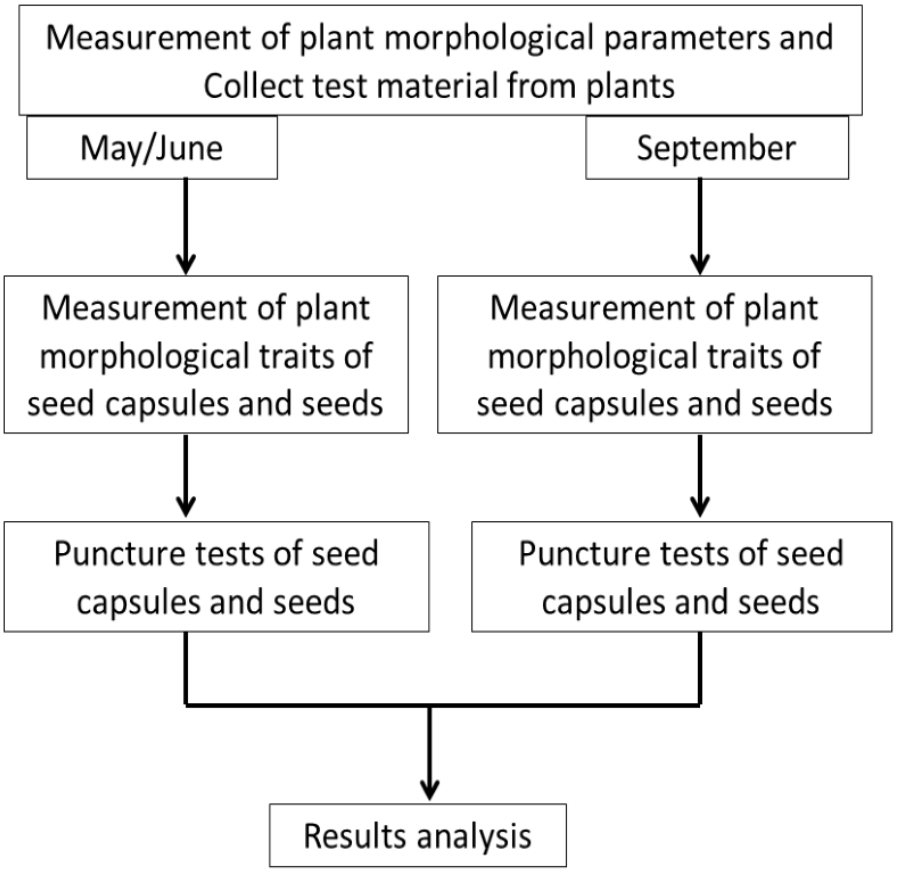
Figure 1. Diagram of the stages of the experiment.